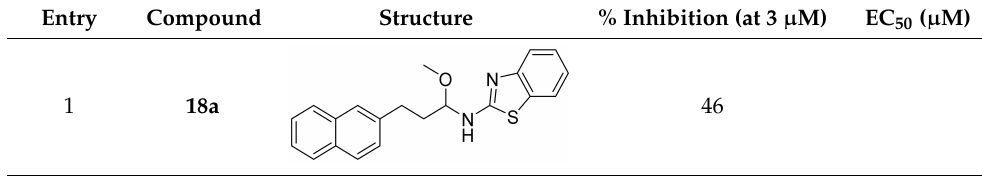
Table 2. Inhibition of PGE 2 generation by N -alkylated 2-aminobenzothiazoles and